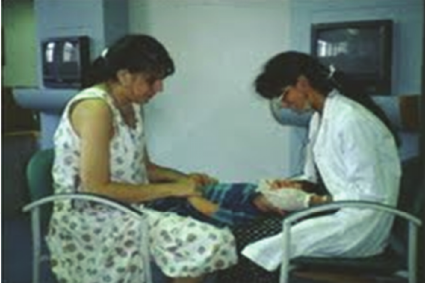
Figure 1: Knee-to-knee examination for infants and